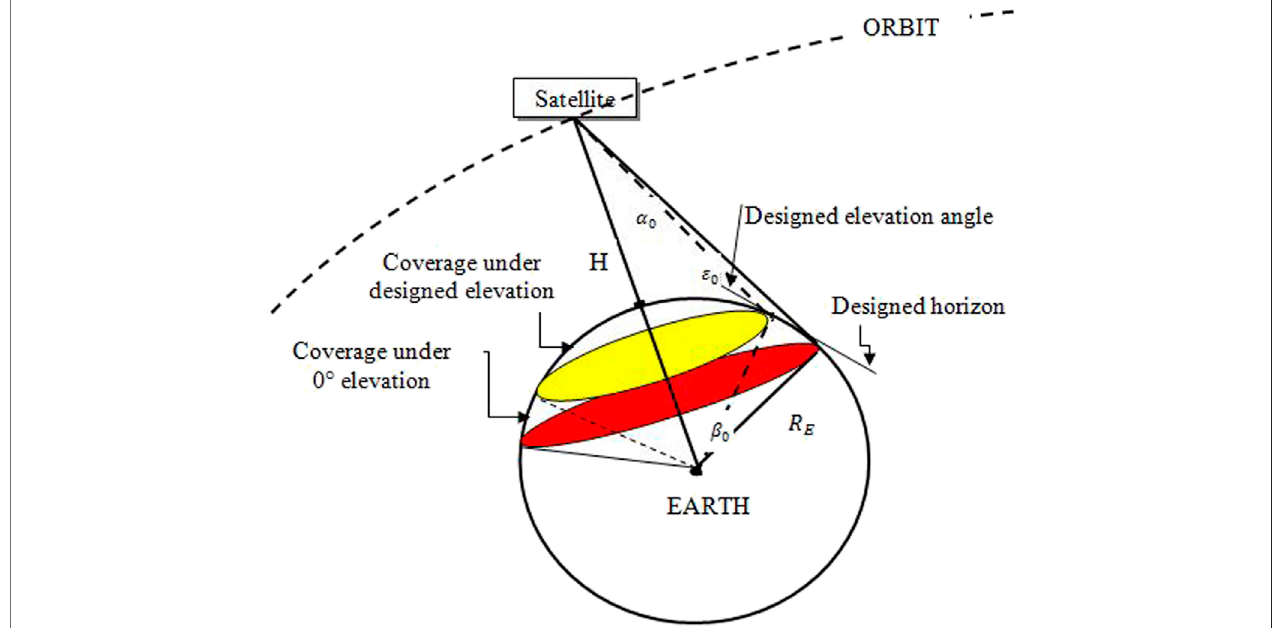
FIGURE 7 | The coverage area concept.